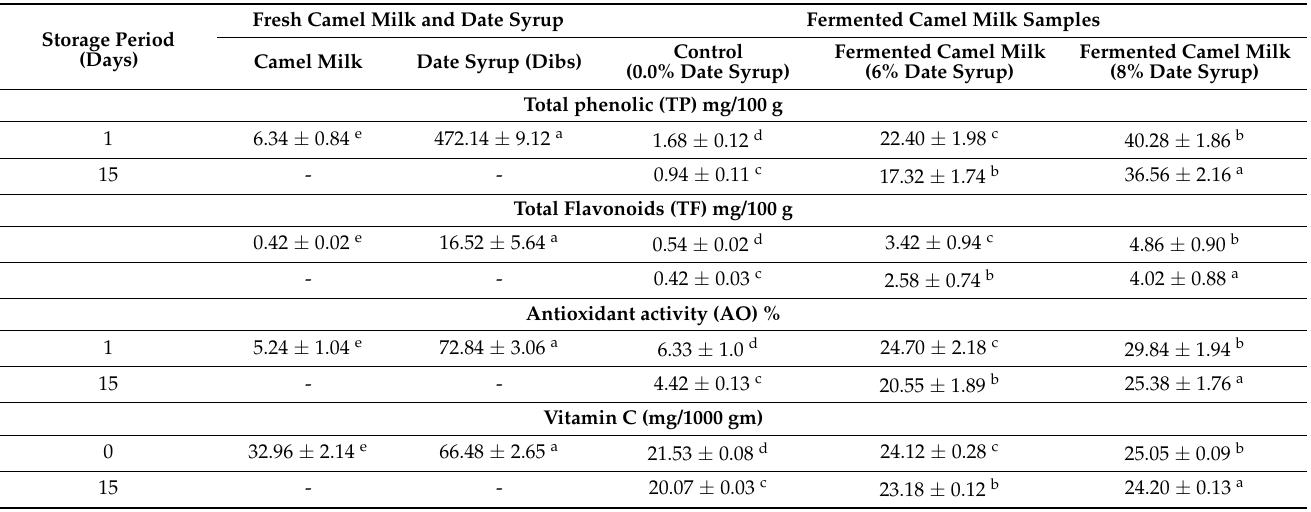
Table 5. Influence of the addition of date syrup on the phytochemical properties of camel milk yogurt during the cooled storage period.